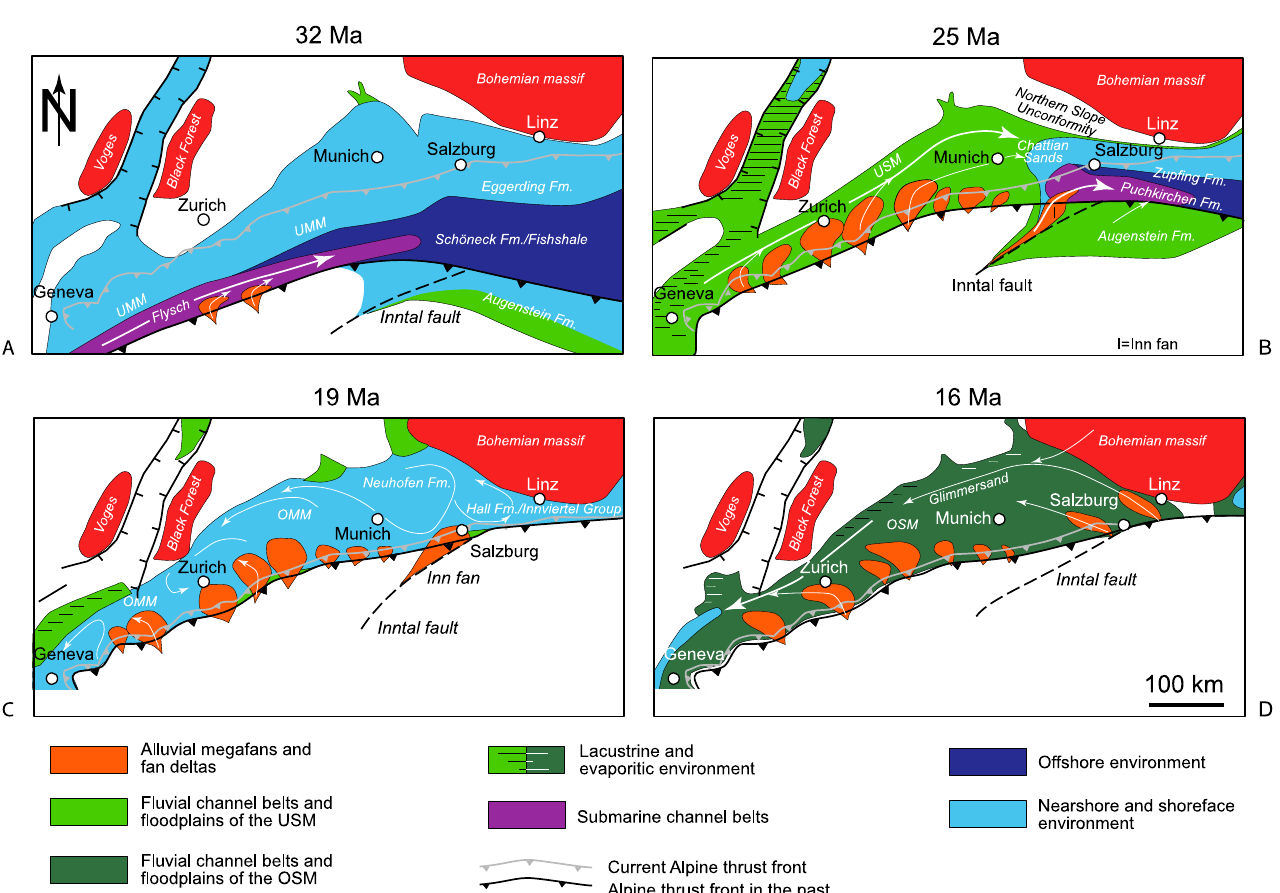
Figure 8. Paleogeography of the Molasse basin. ( A ) Situation at 32 Ma, when the basin axis was occupied by a Flysch trough. Turbidity currents routed the clastic material with sources in the Adriatic continent to the Austrian part of the basin, where offshore marine conditions prevailed. ( B ) The situation changed after 30 Ma, when large sediment fluxes from the rising Alps resulted in overfilled conditions in the central part of the Molasse basin, giving way to the accumulation of the Lower Freshwater Molasse group (USM). The western part was characterized by basin-marginal facies at that time. The fluvial systems in the central Molasse transported the clastic material until the area near Munich, where the terrestrial facies transitioned into the deep Flysch trough of the eastern (Austrian) Molasse basin. There, the largest portion of the supplied sediment was derived from the area near the Periadriatic fault and transported via the paleo-Inn valley into the Flysch trough, as recent provenance tracing has shown [20]. Thick fluvio-deltaic sediments with sources in the adjacent orogen accumulated in a wedge-top position (Augenstein Formation). ( C ) At 19 Ma the eastern Molasse basin became filled and finally transitioned from the Flysch to the Molasse stage, here represented by the Upper Marine Molasse group (OMM). The depositional ream of the Augenstein Formation was uplifted, and its material became eroded and re-deposited to form the rapidly prograding Hall Formation. ( D ) The entire basin was overfilled during the deposition of the Upper Freshwater Molasse group (OSM), and the sediment was transported towards the West. This suggests a reversal in the drainage direction, which occurred during deposition of the Upper Marine Molasse group. Updated and modified from Kuhlemann and Kempf [80]. Reproduced with permission by Elsevier (license number 5315851404282).